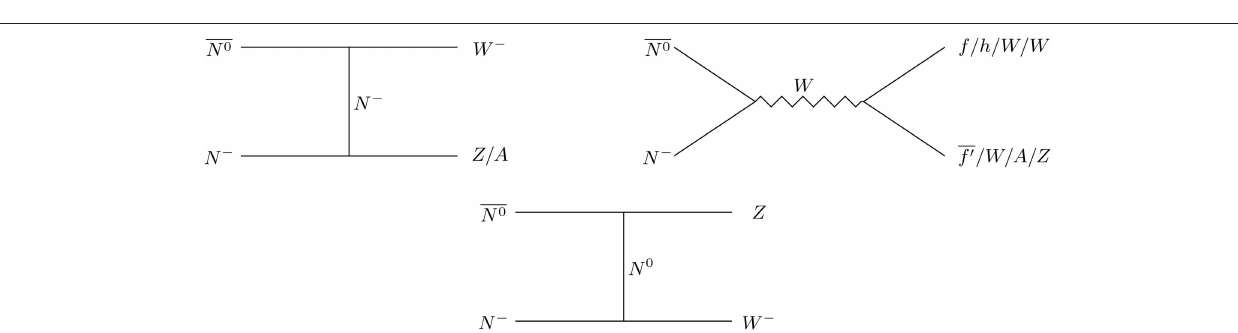
Frontiers in Physics |